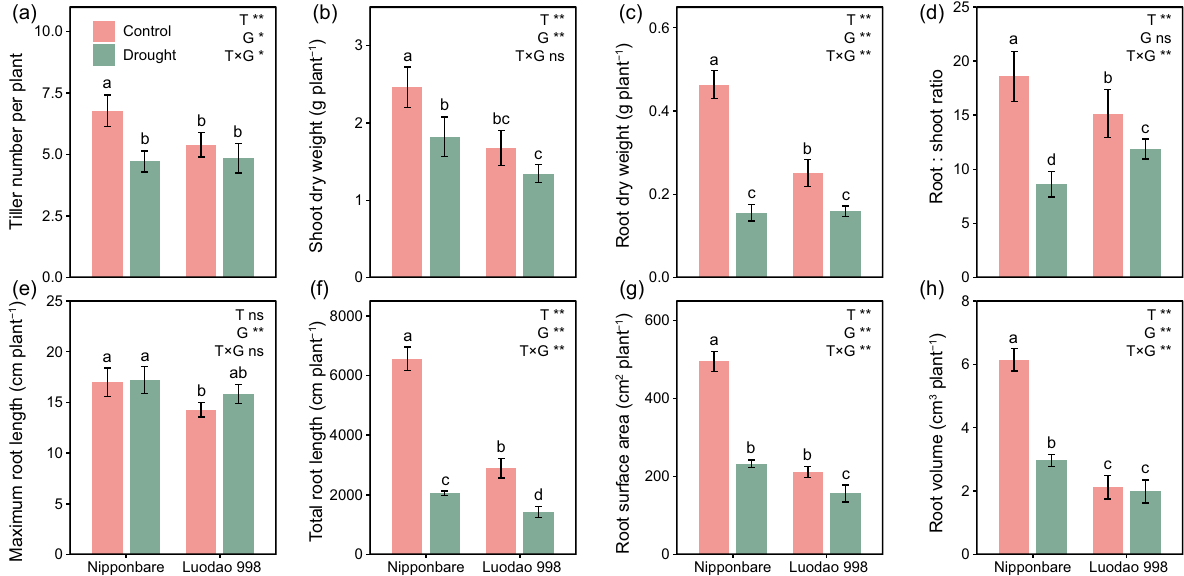
Fig. 1 a Tiller number, b shoot dry weight, c root dry weight, d root: shoot ratio, and e – h root traits as affected by drought and genotype. Error bars represent standard deviation (n 4). Different letters ( p < 0.05) and asterisks (* p < 0.05 and ** p < 0.01) indicate significant differences as defined by = two-way ANOVA with LSD test. “ns” means non-significant difference. T Treatment, G